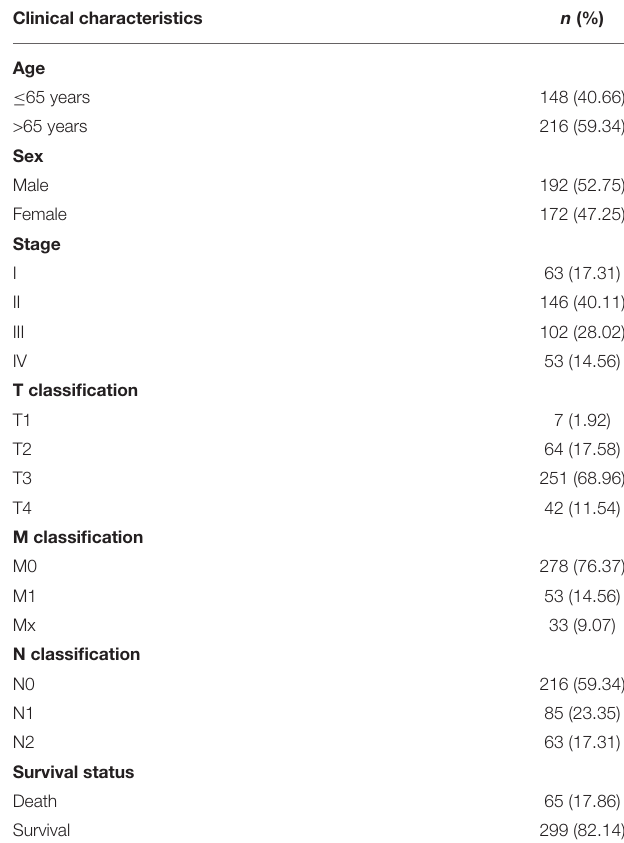
TABLE 1 | Clinical characteristics of patients with colon